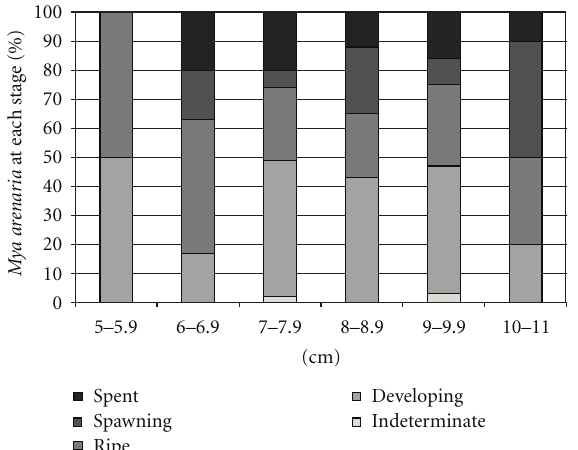
Figure 5: Relationship between female Mya arenaria length and stage of gametogenesis.